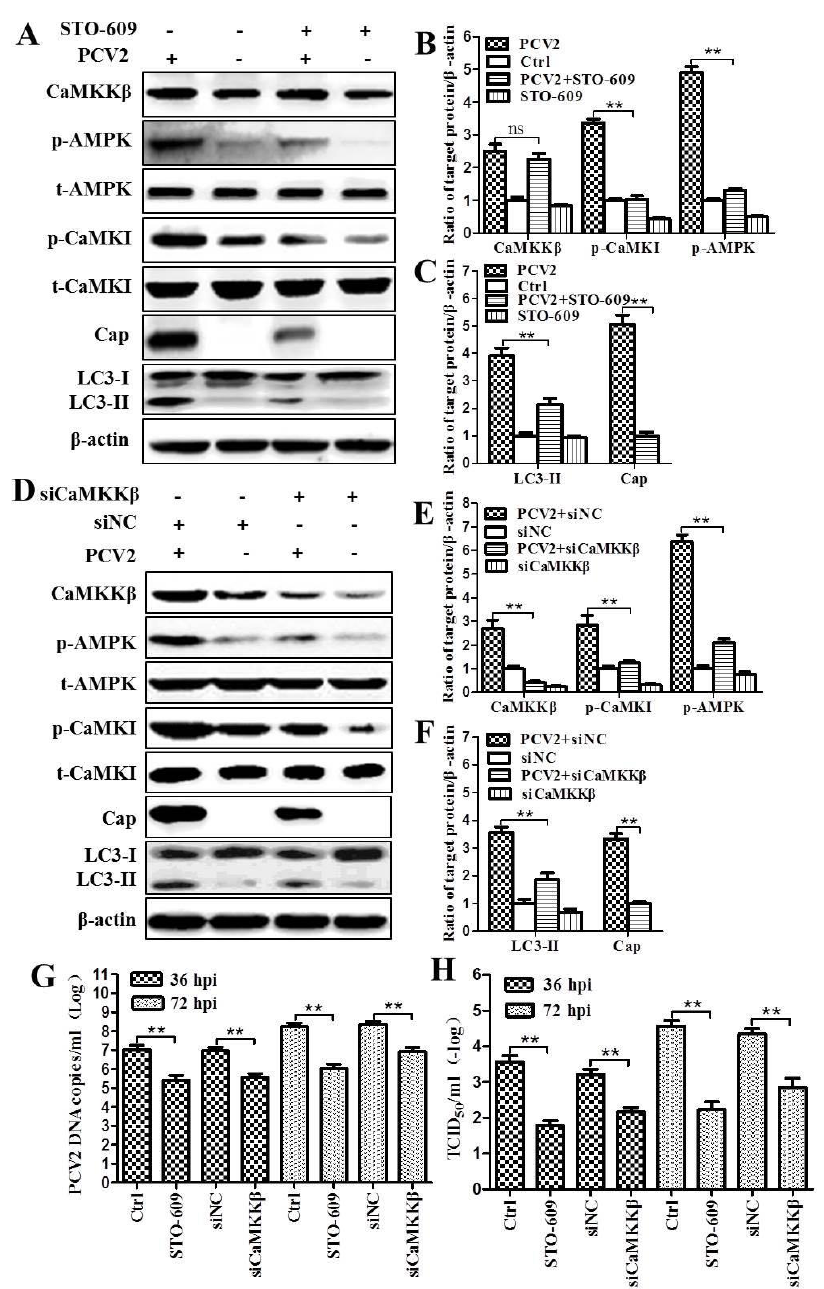
Figure 2. Inhibition of CaMKKβ by STO-609 or RNA silencing downregulated p-AMPK, p-CaMKI, and LC3-II as well as reduced replication of PCV2. PK-15 cells were infected with PCV2 (MOI ≈ 1) in the presence of STO-609 (10 μM) or siRNA targeting CaMKKβ (siCaMKKβ) for the indicated time points. Whole cell lysates at 36 hpi were subjected to Western blotting ( A – F ). ( A , D ) Representative images of Western blotting for target proteins of cells treated with STO-609 ( A ) or siCaMKK β ( D ) at 36 hpi. ( B , E ) Ratios of CaMKK β , p-AMPK and p-CaMKI to β -actin of panels A and D. ( C , F ) Ratios of LC3-II and viral capsid (Cap) protein to β -actin as represented by panels A and D. PCV2-infected cells treated with STO-609 or siCaMKK β were used for quantitative real-time PCR ( G ) and virus titer (50% tissue culture infective dose (TCID 50 )) ( H ) at 36 and 72 hpi. Ratios of targeted proteins to β -actin were normalized to mock infection set at 1.0. All statistical data are reported as the mean ˘ SEM of three independent experiments (ns, p > 0.05; * p < 0.05; and ** p <